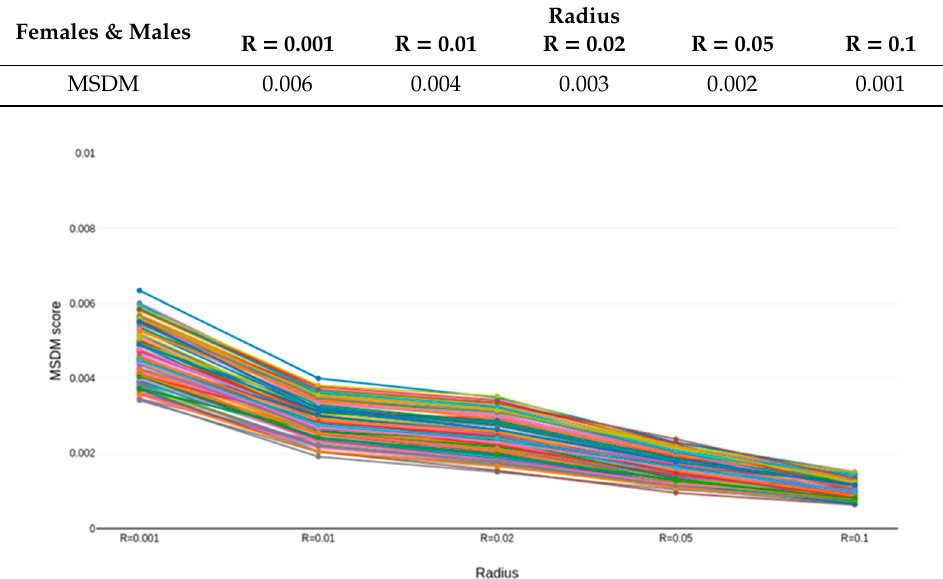
Table 3. Mean 3D mesh distortion metric (MSDM) scores of females and males in the testing database for five different radius values.